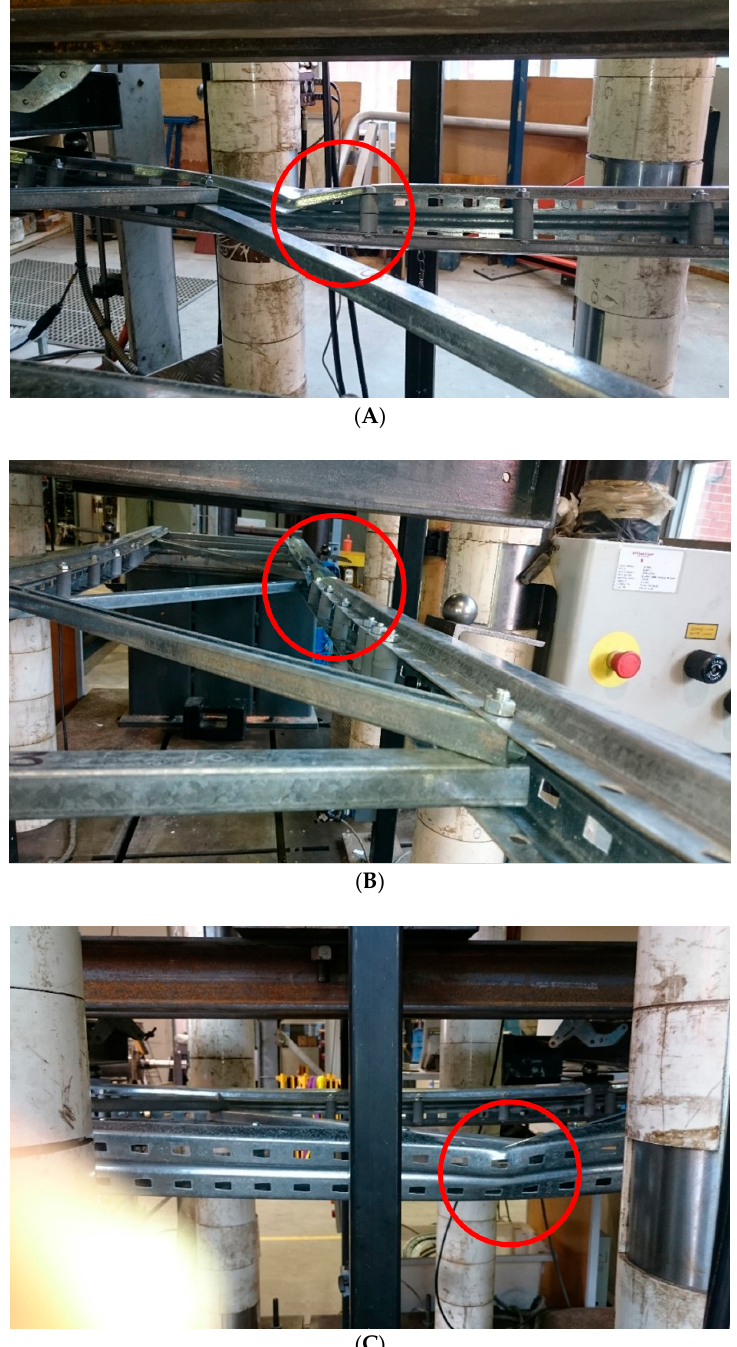
Figure 12. The observed failure mode for reinforced specimens with 200 mm reinforcing pitch during the major axis test: ( A ) 200RMJM-test1; ( B ) 200RMJM-test2; ( C ) 200RMJM-test3.